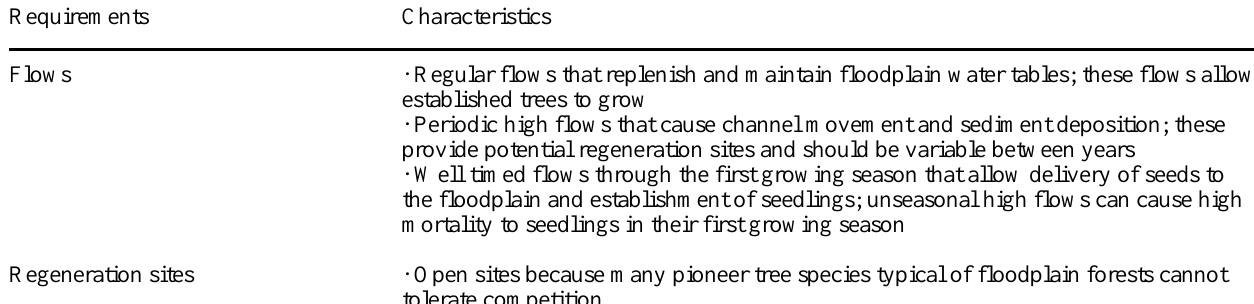
Table 1. Conditions required for the regeneration of many floodplain forest tree species in Europe. Requirements